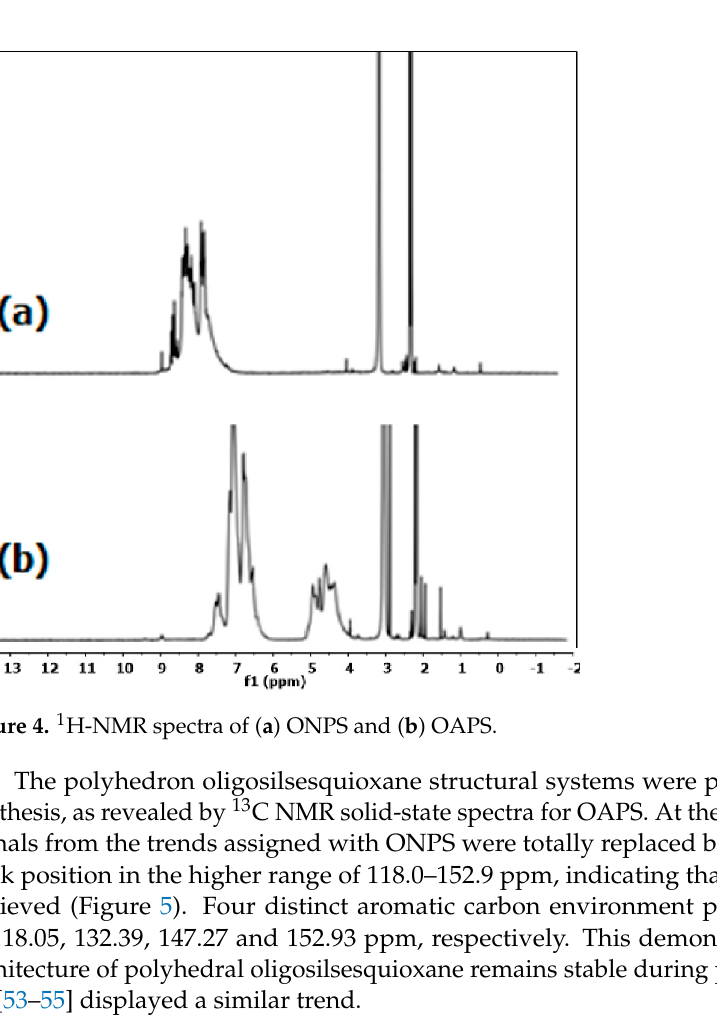
8 of 19 Figure 3. Stack plot comparing, ( a ). (black) ONPS and (red) OAPS ( b ) the FTIR spectra of as- synthesized (black curve) COF-S7, (red curve) OAPS and (blue curve) 2-MeAQ ( c ) (black curve) COF-S12, (red curve) OAPS, and (blue curve) TPA. COF-S7 and COF-S12 exhibited the υ C=N stretching of amine functions ( υ C=N = 1593 cm − 1 and 1585 cm − 1 , respectively (Figure 1)). Similar studies are in conformity with this [48–50]. Noticeably, the Si–O–Si spectrum in COF-S7 and COF-S12 was observed at the 1104 cm − 1 and 1086 cm − 1 absorption bands. Similar reported research by [51] is in agreement with this. The NMR spectrum and 1 H NMR spectra of ONPS and OAPS were examined in deuterium acetone (acetone-d 6 ), Figure 4. In the 1 H NMR spectrum of OAPS, the aromatic hydrogens of OAPS were observed to display a strong chemical shift (7.47–6.34 ppm) due to the electron-donor abilities of the substituents (NH 2 ) on phenyl rings; those for the amino protons were in the range of 4.0–5.0 ppm, which is in a ratio of 2:1. A previous study by [52] is in agreement with this. Due to the electro-withdrawing effects of nitro groups (NO 2 ) on the phenyl ring of the ONPS, the signals relating to aromatic hydrogen protons were found in the range of ONPS at lower chemical shift (8.7–7.8 ppm).